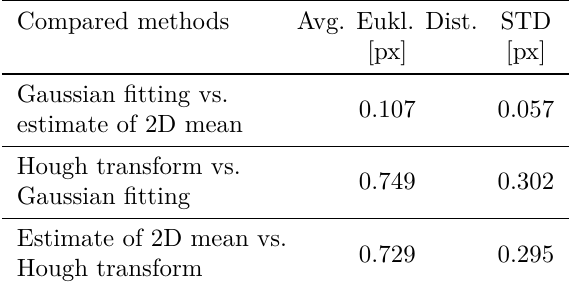
Table 1. Comparison of euclidean distance between the location of protons impacts and its standard devi-